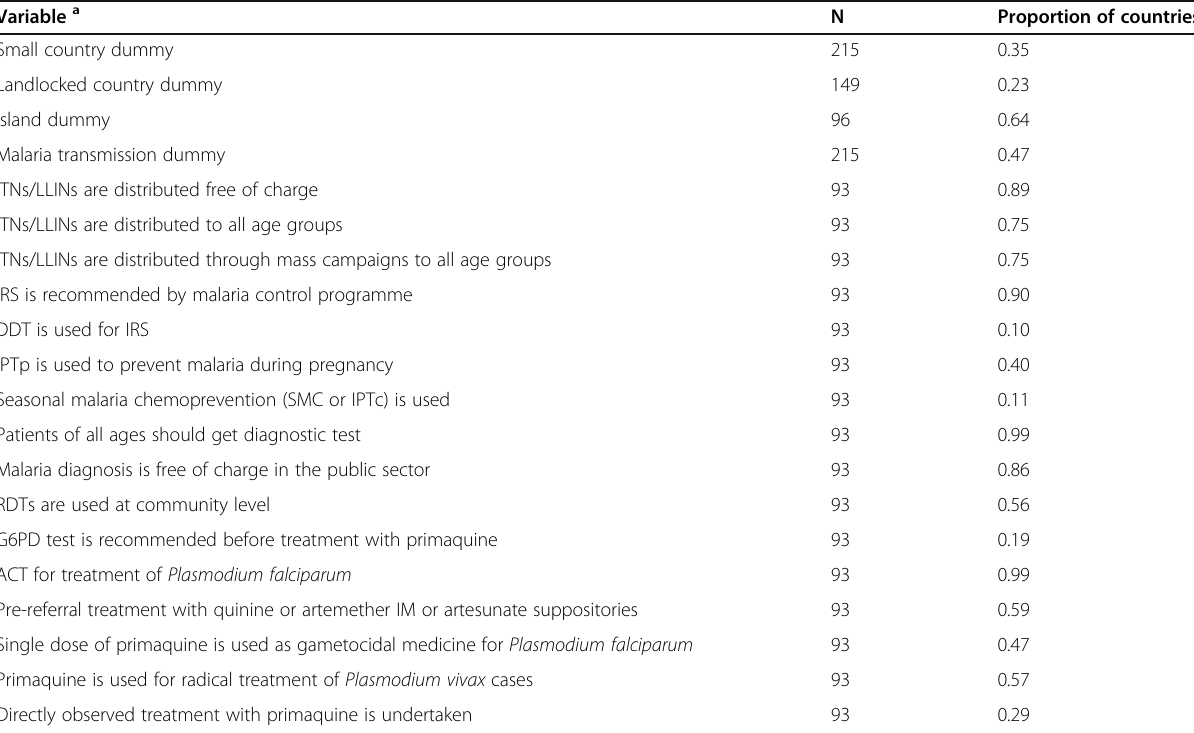
Table 2 Summary statistics of categorical variables Variable